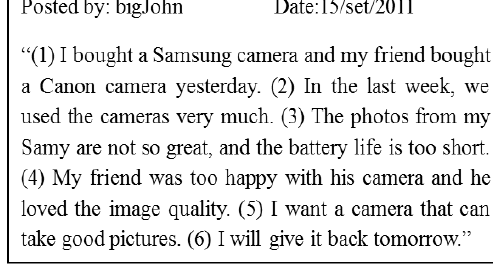
Figure 2. Example of opinion text or review (Adapted from Liu